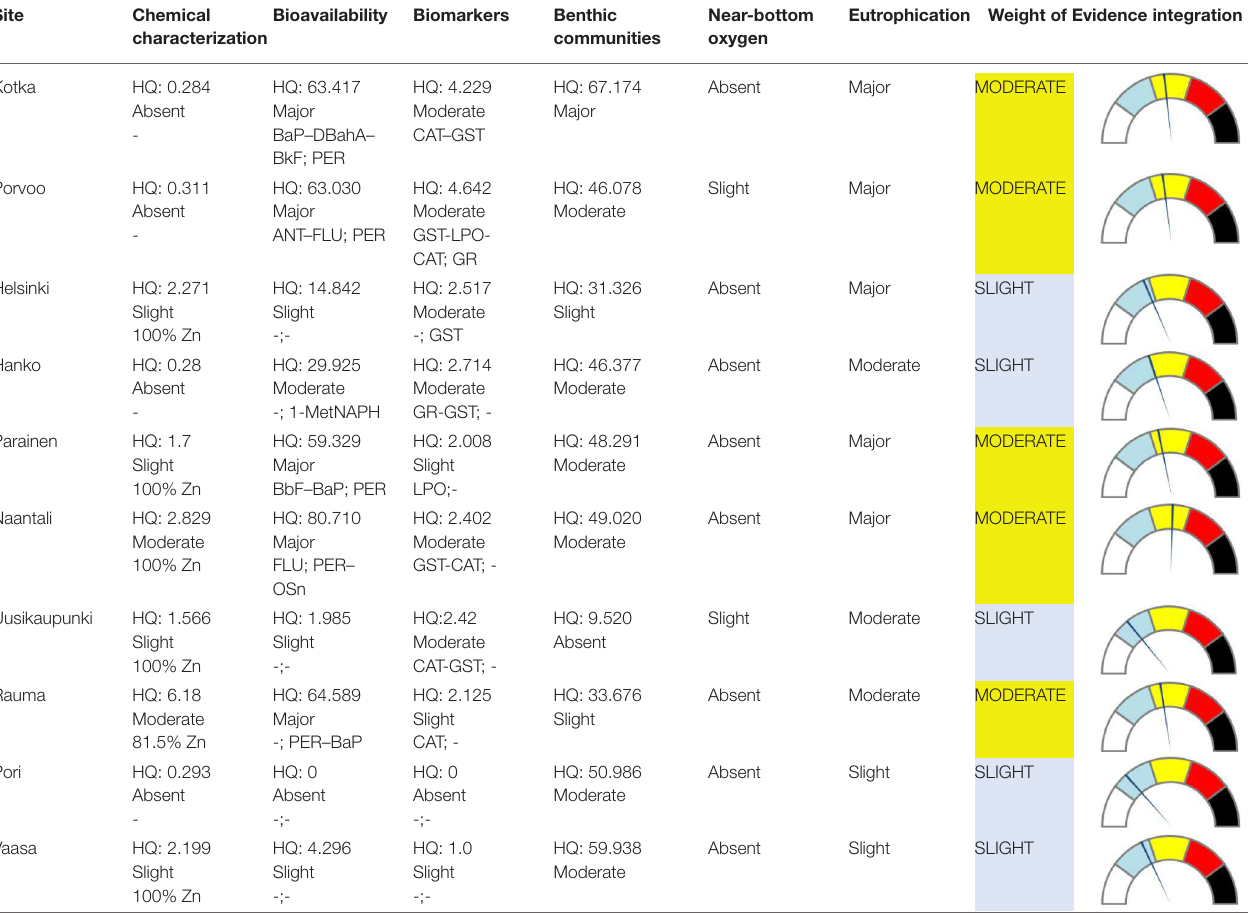
TABLE 3 | Elaborations with levels of hazard assigned to the different LOEs and the final WOE.